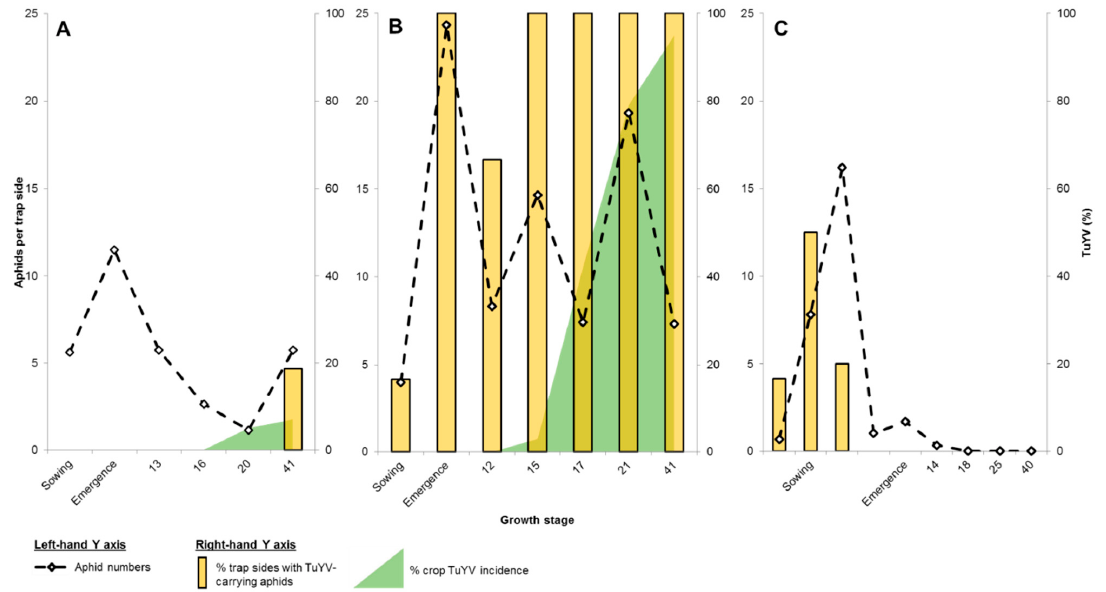
Figure 1. Aphid numbers, percentage (%) of trap sides with Turnip yellows virus (TuYV)-carrying aphids and canola ( Brassica napus ) crop virus incidence over the early period of the growing season at Coomalbidgup in 2017 ( A ) and 2018 ( B ), and at South Stirlings in 2018 ( C ). At each site, three double-sided yellow sticky traps were tied to the top of the fence and collected every two weeks. Aphids caught on each trap side were counted, pooled, homogenized, and the crude extract tested for TuYV by reverse transcription loop-mediated isothermal amplification. For canola crops, tip leaf samples of 100 to 200 plants tested for TuYV from ~GS12 (two-leaf stage; ‘BBCH’ decimal system, Lancashire et al 1991) by enzyme-linked immunosorbent assay.